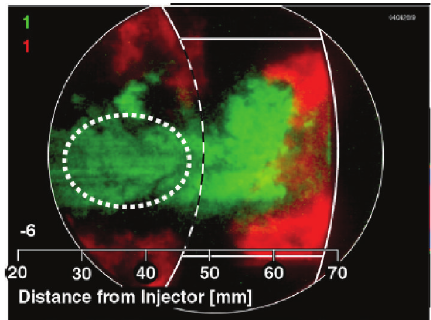
Figure 19: OH (green, OH-PLIF) throughout jet cross section, with soot (red, soot luminosity) only at head of jet